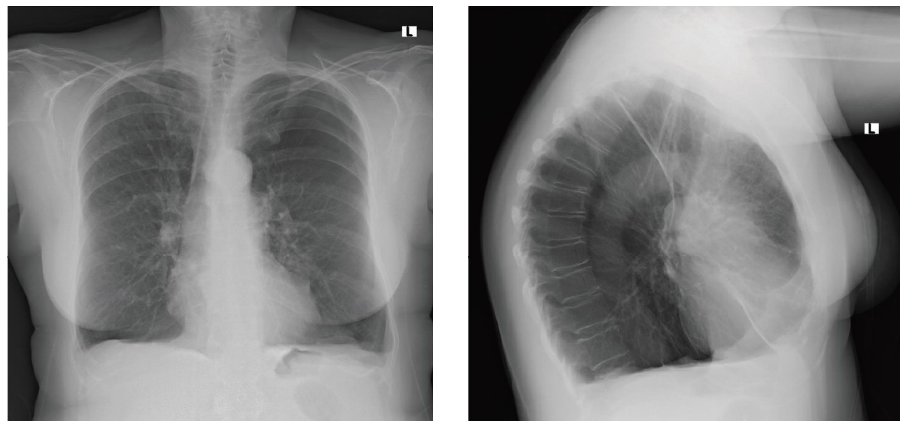
Figure 1: Chest X-rays of posterioanterior and lateral view showing bilateral lung hyperinfation, diaphragm fattening, and